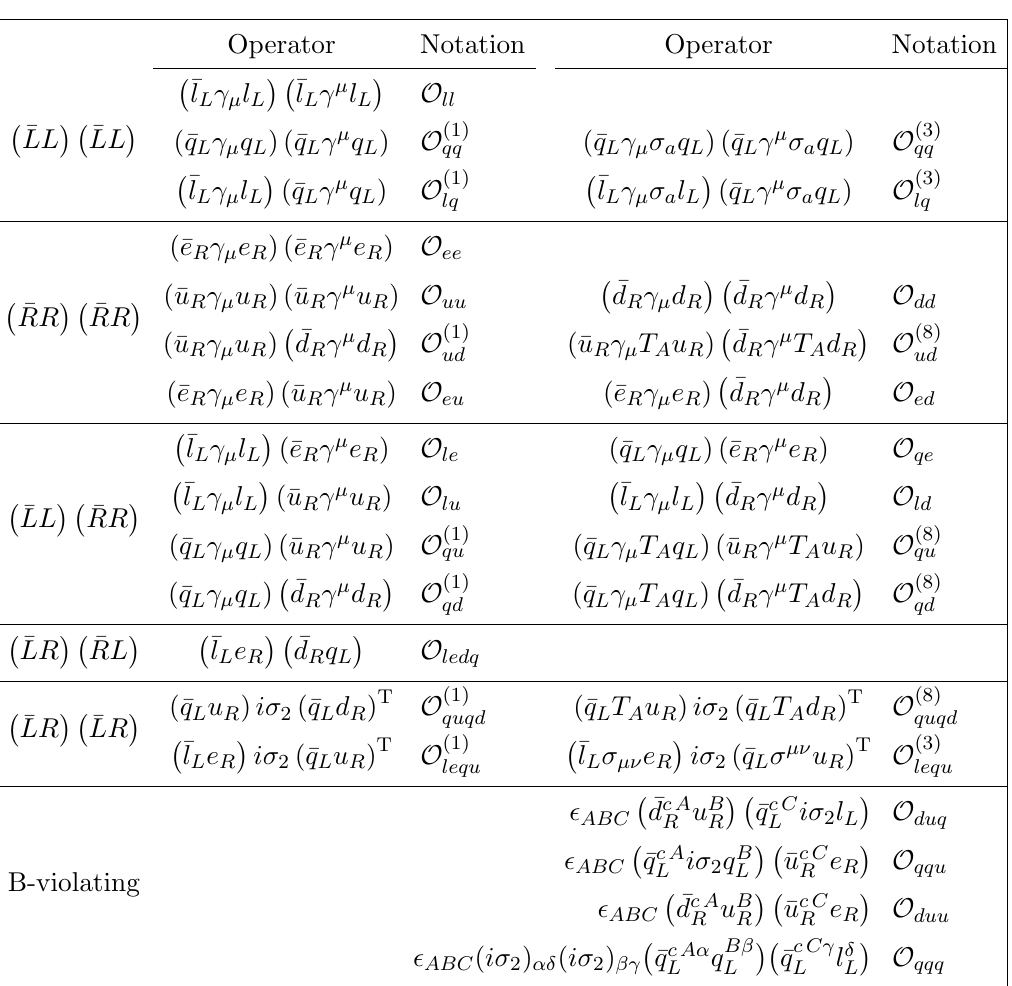
Table 5 . Basis of dimension-six operators: four-fermion interactions. Flavor indices are